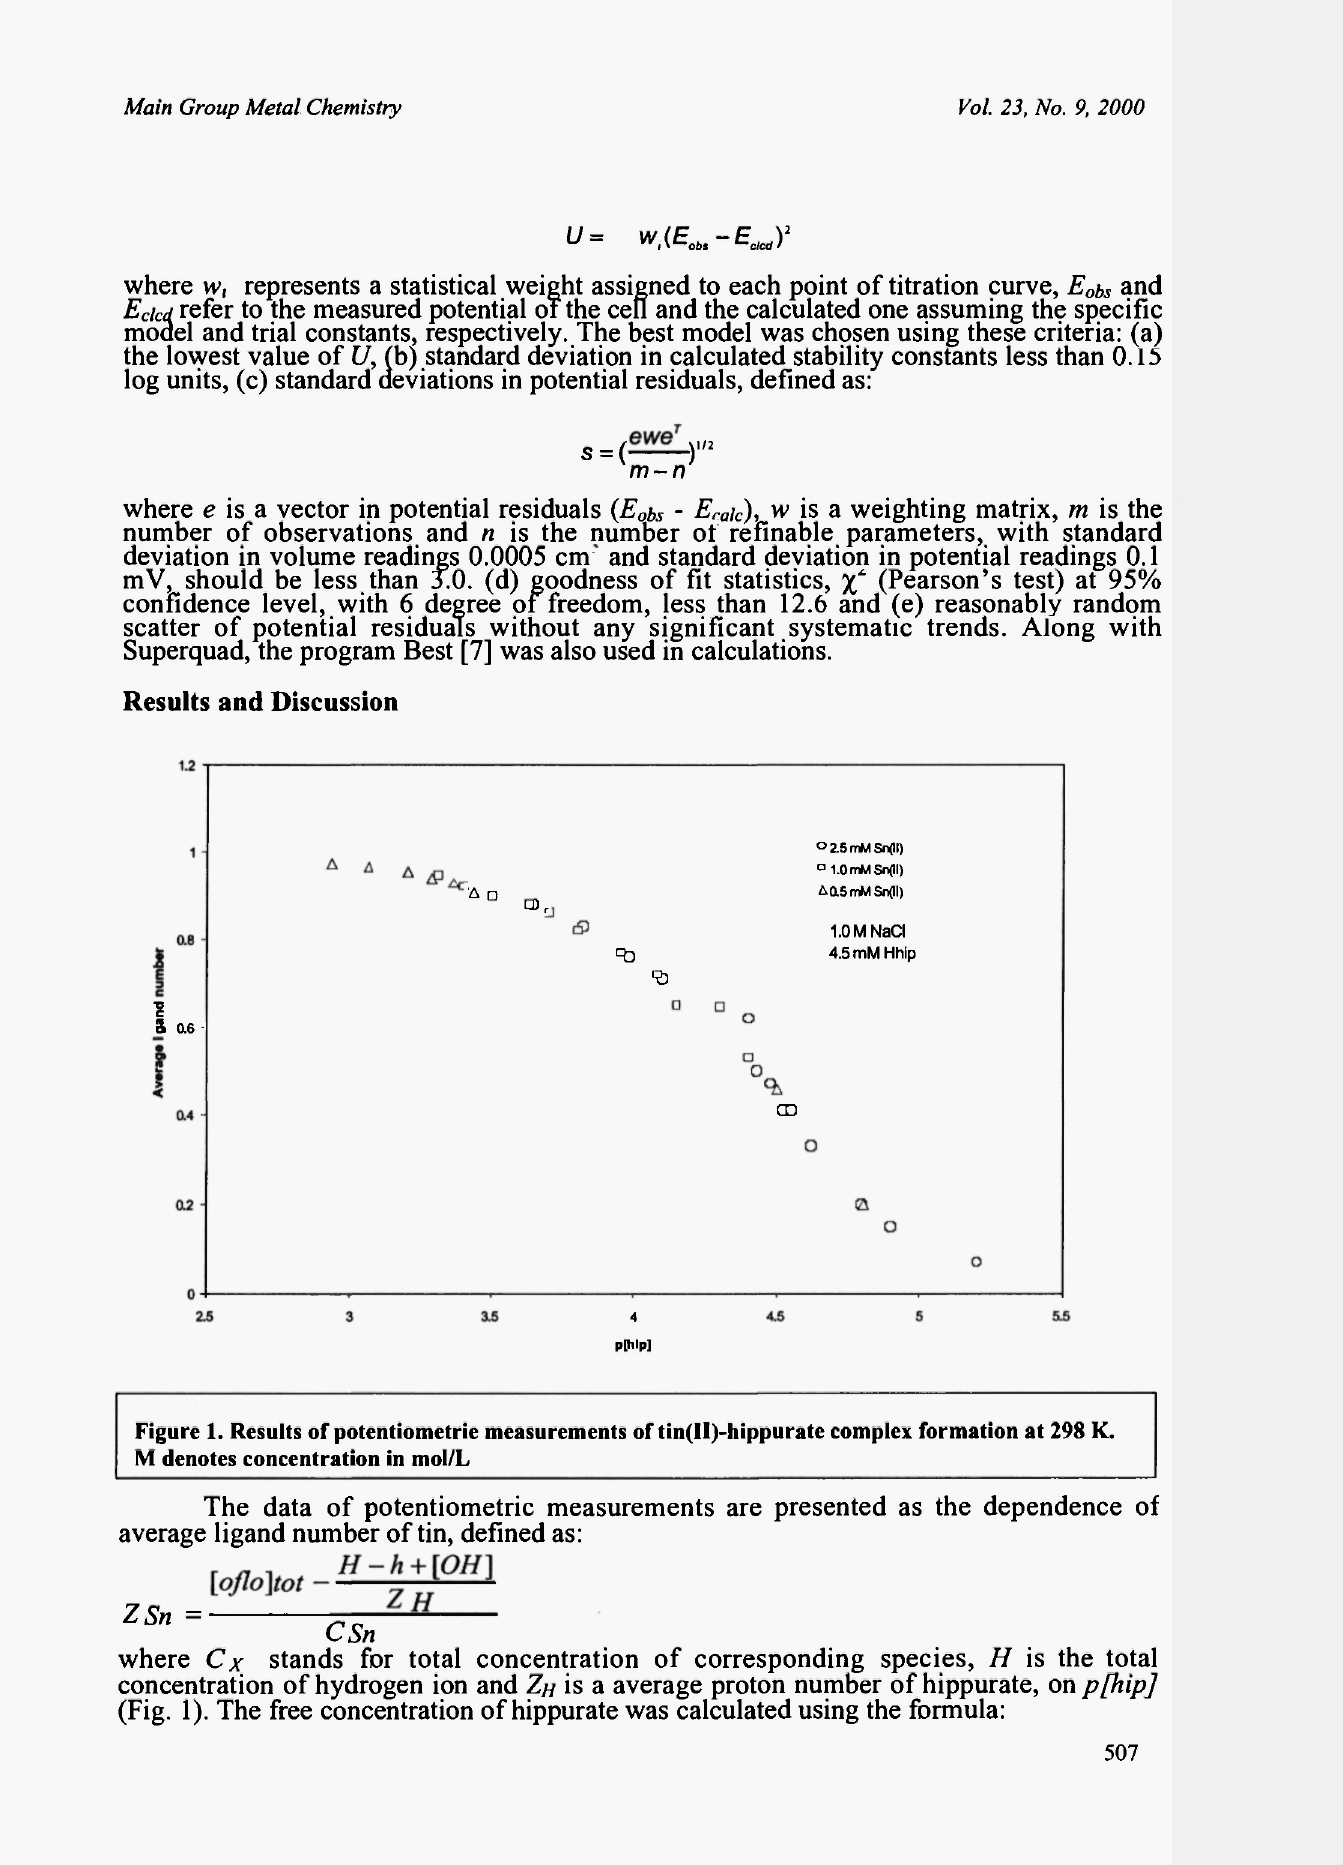
Figure 1. Results of Potentiometrie measurements of tin(ll)-hippurate complex formation at 298 K. Μ denotes concentration in